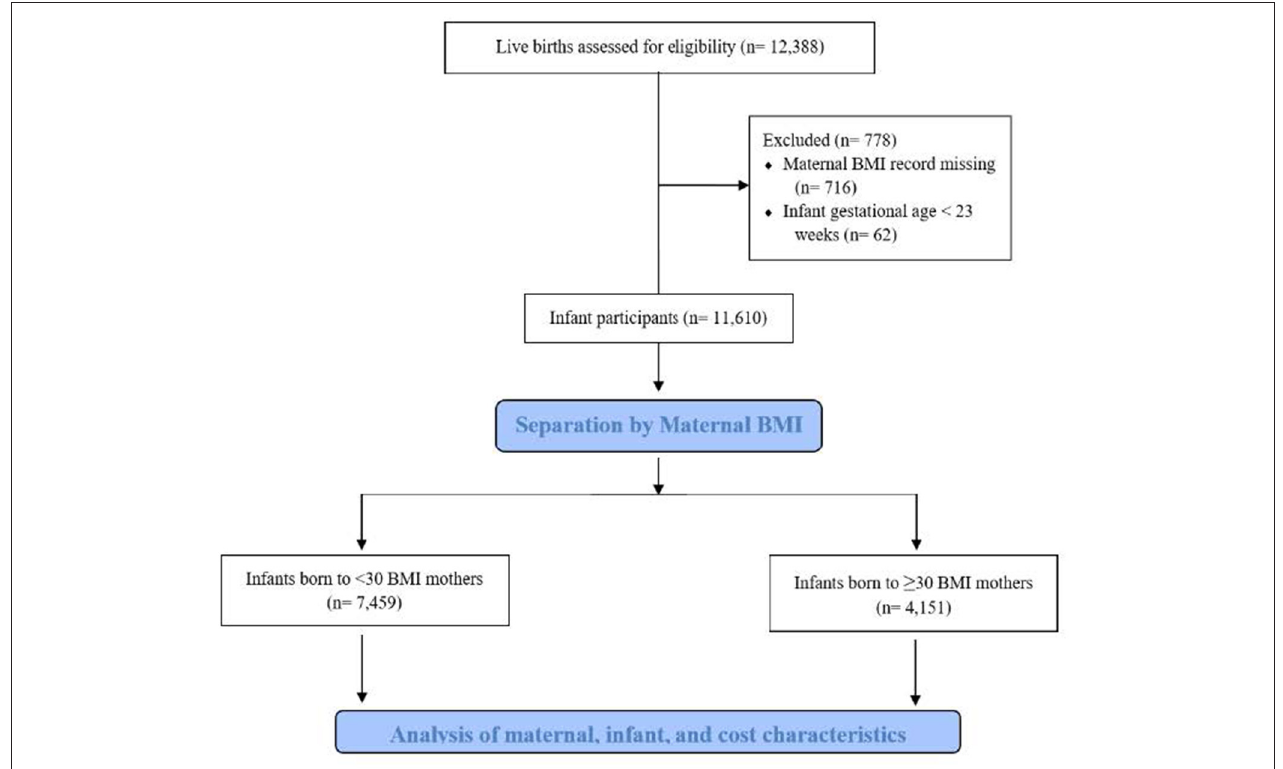
FIGURE 1 | Consort